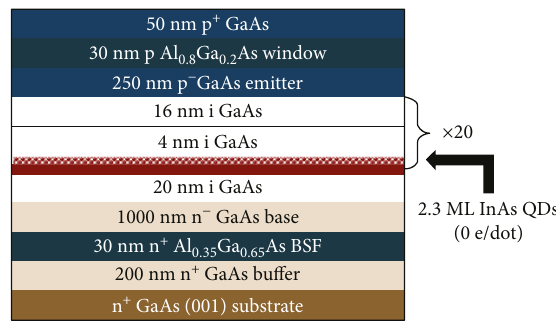
Figure 2: Sketch of the epilayer structure of the 20 × QD solar cell (R3 and R4